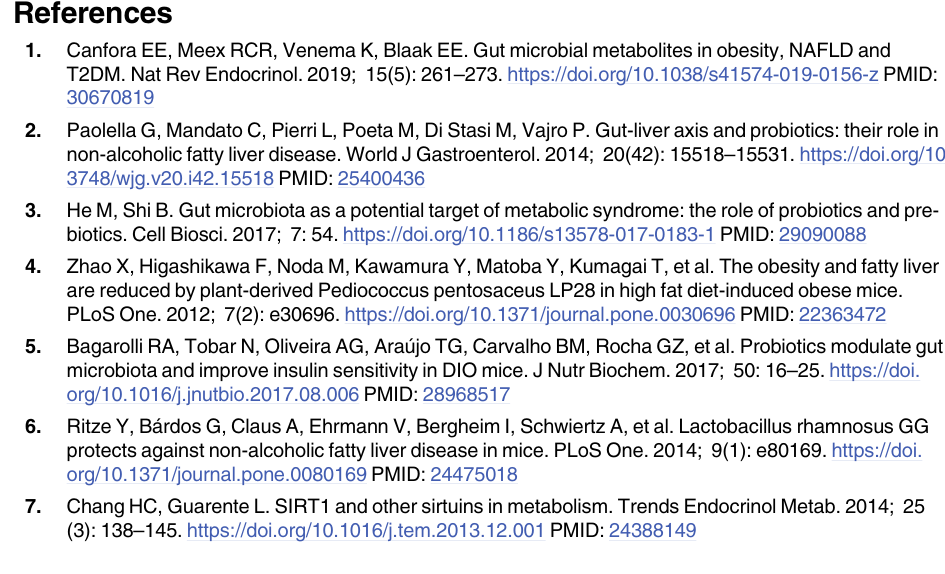
S1 Fig. There is no difference in lipogenic gene expression in the liver and adipose tissue. (A-D) Lipogenic gene expression in the liver, MAT, SAT, and BAT, respectively. All genes are normalized to expression of β -actin. Data present mean ± SD for 7~8 mice in each group. Stu- dent’s two-tailed t-test was used for analysis difference between experimental groups. Student’s two-tailed t-test was used for analysis of differences between groups. #, •, +, � p < 0.05, ##, ••, ++, ��